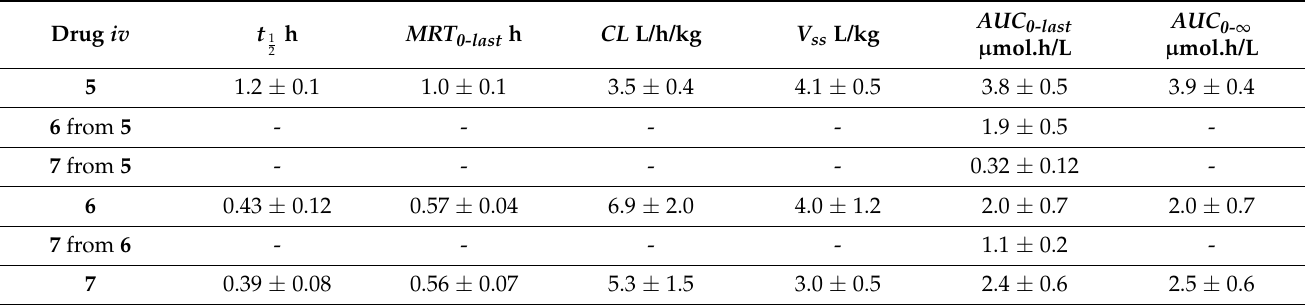
Table 3. Pharmacokinetic parameters calculated from the intravenous administration ( iv ) of 5 mg/kg artemiside 5 , artemisox 6 , and artemisone 7 to male C57/BL6 mice together with their respective metabolites formed in situ a . Drug iv